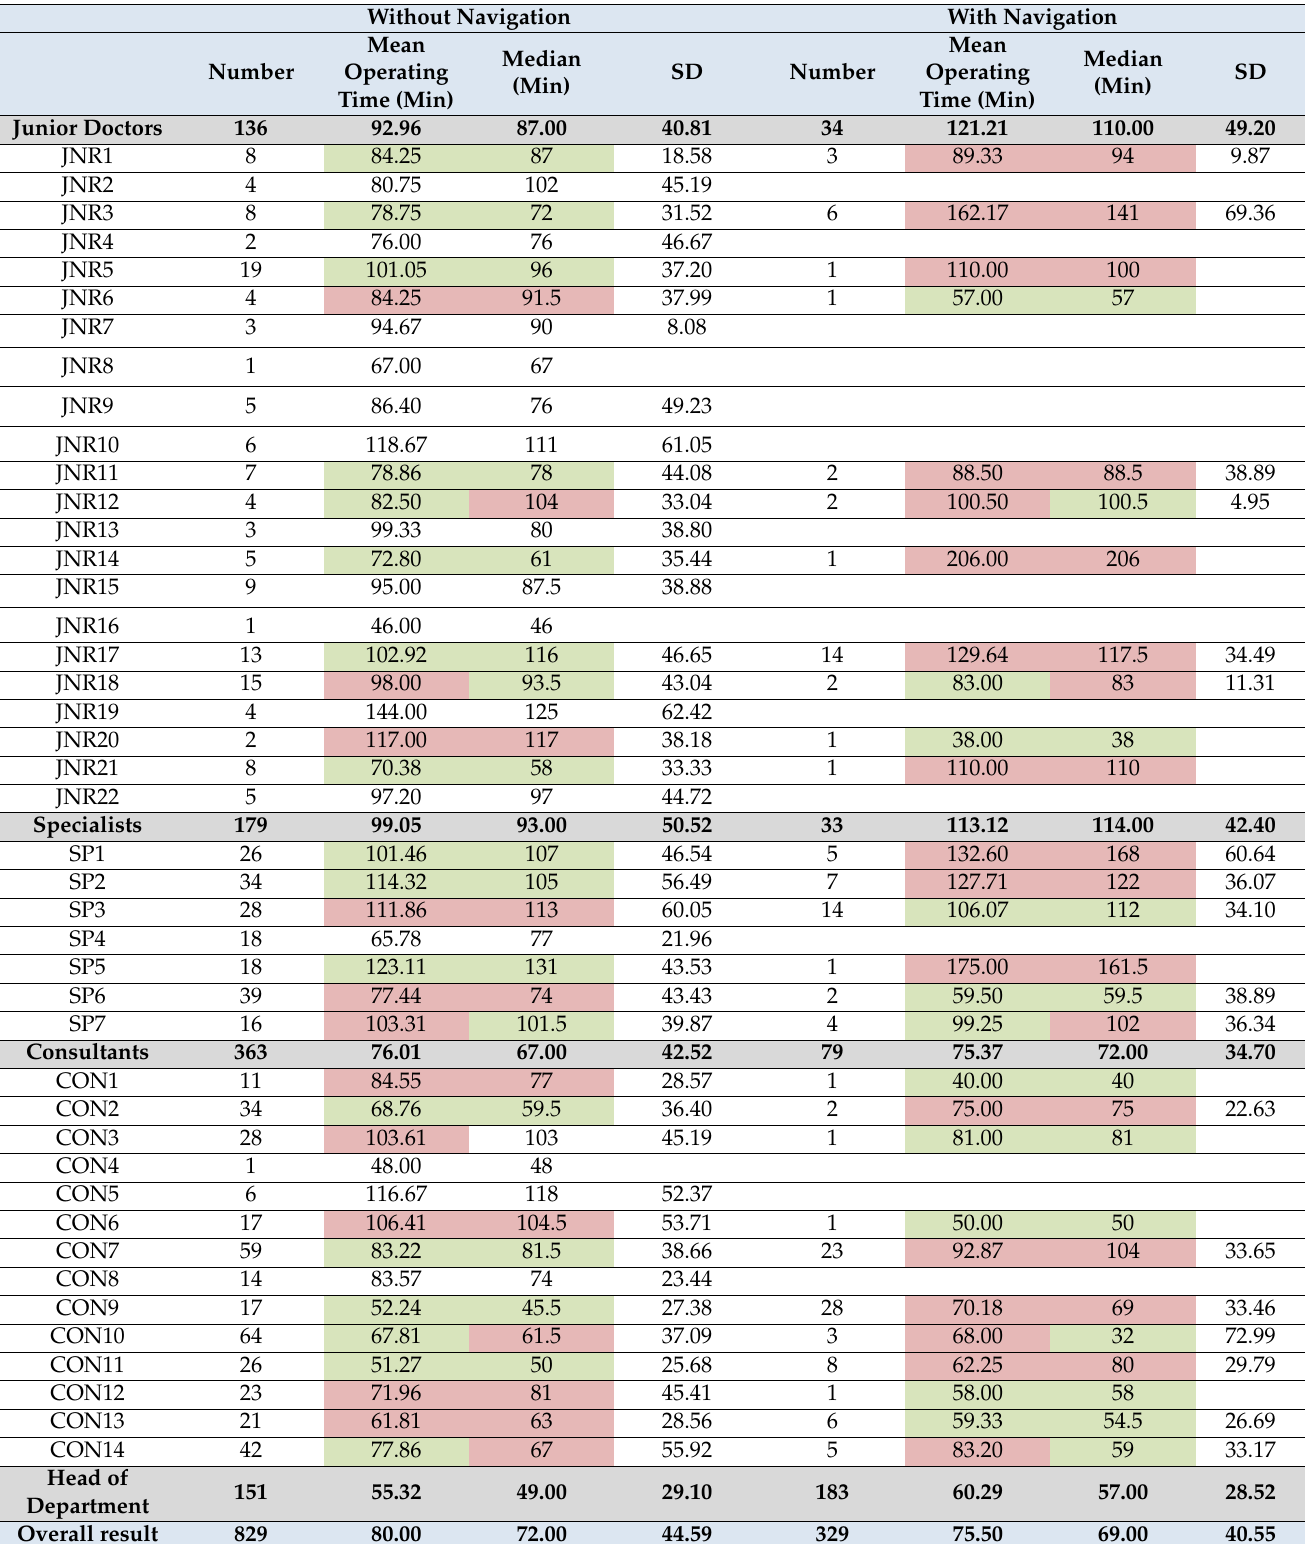
Table 6. Overview of results. (JNR: Junior Doctor; SP: Specialist; CON: Consultant; HD: Head of Department; Number: number of operations performed by each rank of physician; Median: median time; SD: standard deviation; highlighted in green: shorter mean operating time; highlighted in red: longer mean operating